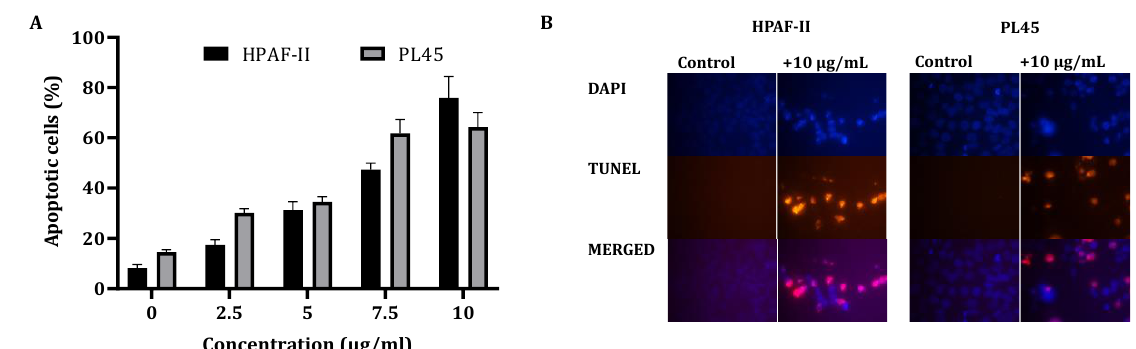
Figure 2. Detection of apoptotic cells using Annexin-V/PI double-staining ( A ) and the TUNEL assay ( B ). ( A ) PL45 and HPAF-II cells were treated with CSE 2.5, 5, 7.5 and 10 µ g/mL for 4 h, and a flow cytometric analysis of Annexin V-FITC/PI was performed. The data is presented as the mean (total apoptotic cells) ± SE. Statistical significance was determined by the Kruskal–Wallis test, p < 0.05, and Mann–Whitney for the post hoc, p < 0.0125. ( B ) PL45 and HPAF cells were treated with 10 µ g/mL for 4 h, and the TUNEL assay was performed. Illustrations are representatives of three independent experiments. Blue-colored cells (DAPI) are living cells; red-colored cells (fluorescence-labeled dUTP) are apoptotic cells. Cells were visualized by fluorescence microscopy (original magnification ×20).